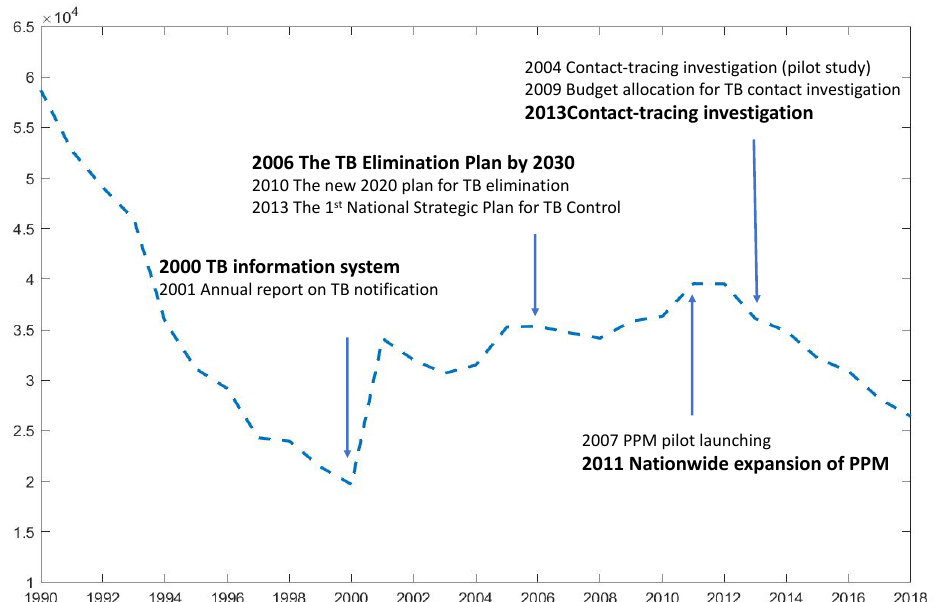
Figure 1. Annual TB incidence and various interventions at the national level are displayed from 1990 to 2018. Note that the annual incidence of TB was increased owing to a new TB surveillance system implemented by the Korean government in 2000. The PPM began on a pilot scale in 2007 and expanded to all of Korea in